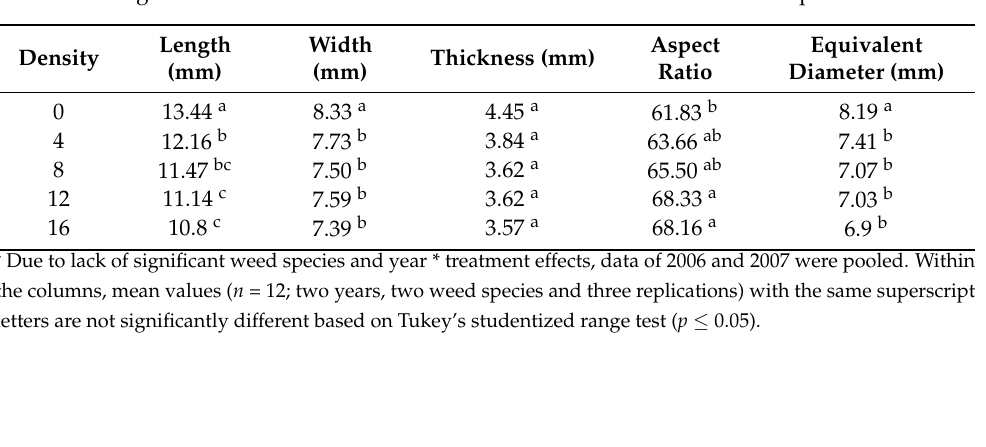
Table 2. Basic geometric characteristics of maize seeds as affected with weed competition